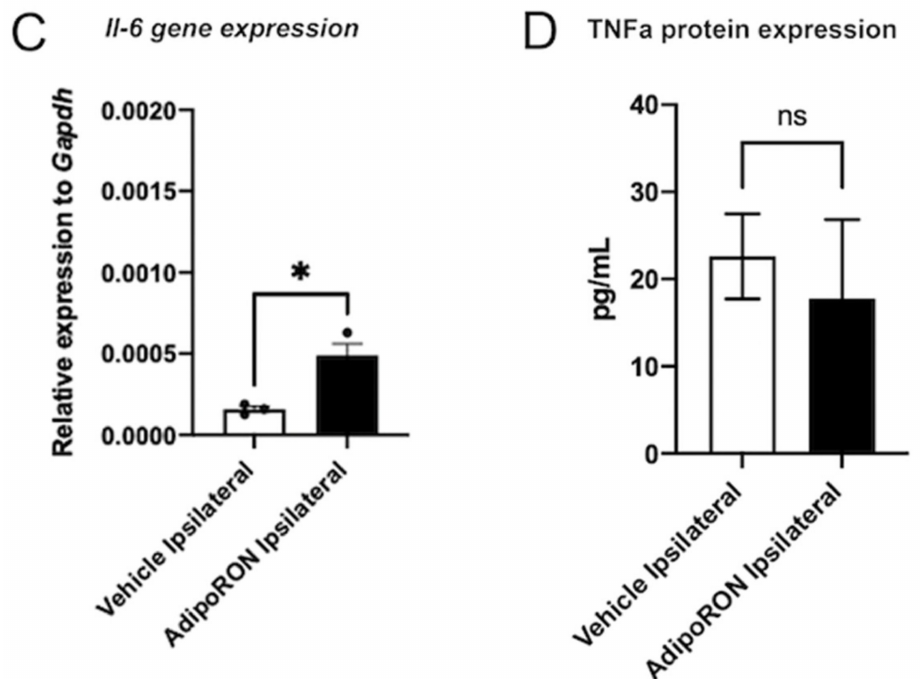
Figure 9. AdipoRON has no effect on inflammatory cytokine expression in the ipsilateral hemisphere. ( A–C ) Nf κβ , Il-6 and Tnf α gene expression in the ipsilateral hemispheres of Vehicle and AdipoRON- treated groups. ( D ) TNF α ELISA quantification showing no difference in the ipsilateral hemispheres of both groups ( n = 3). * p <